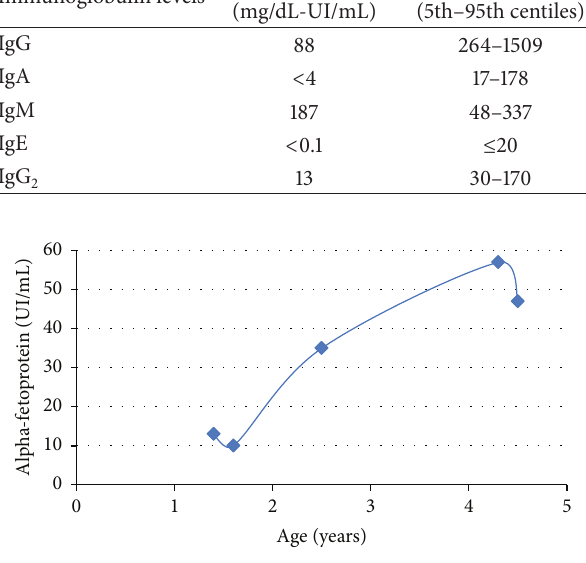
Figure 2: Alpha-fetoprotein